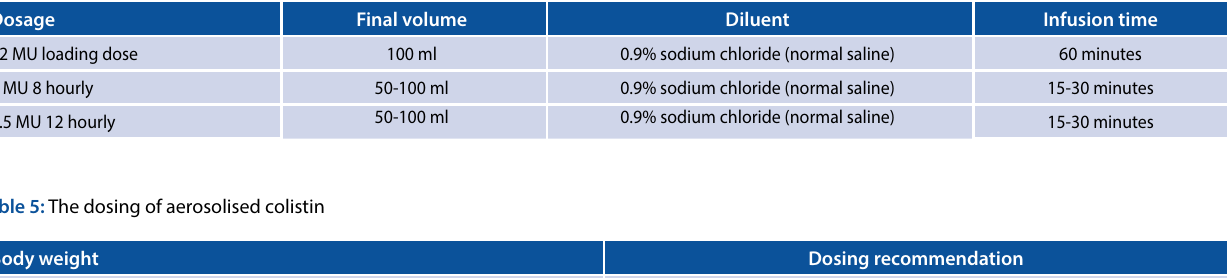
Table 4: Colistin (CMS) reconstitution outline information Dosage